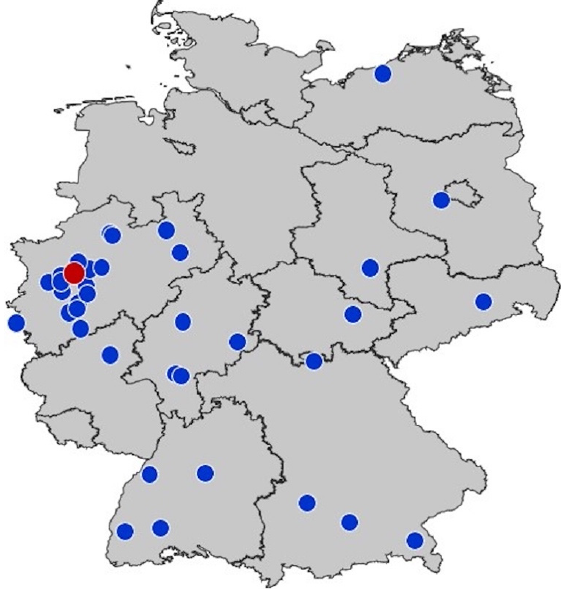
Figure 2. Localization of the participating PICUs. Each circle represents one center. The main study center in Essen (red) is located in the cluster in North Rhine-Westphalia, where 21.6% of the German population live. Table 1. Patient characteristics.